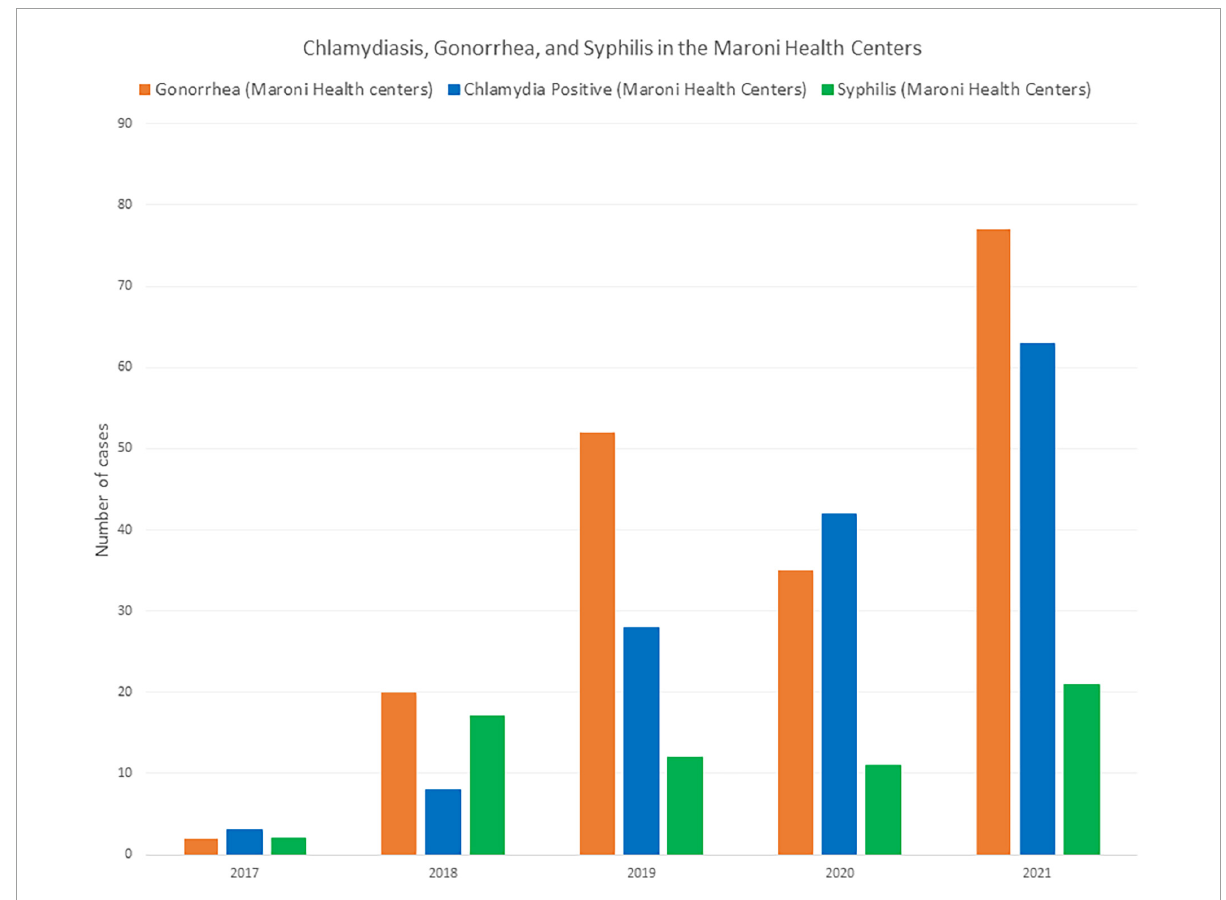
FIGURE12 In the health centers on the French side of the Maroni river the number of diagnoses of sexually transmitted diseases (Syphilis, gonorrhea, and chlamydiasis) has greatly increased over time, notably since the addition of